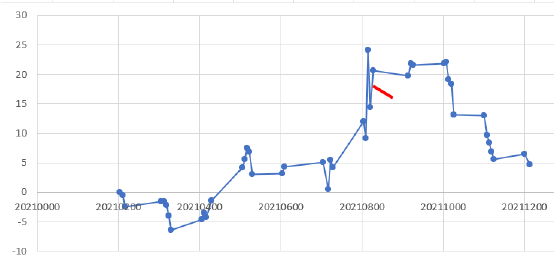
Figure 3. Surface displacement in mm where the collapsed building stands, the redline indicates the date of collapsing 24.08.2021